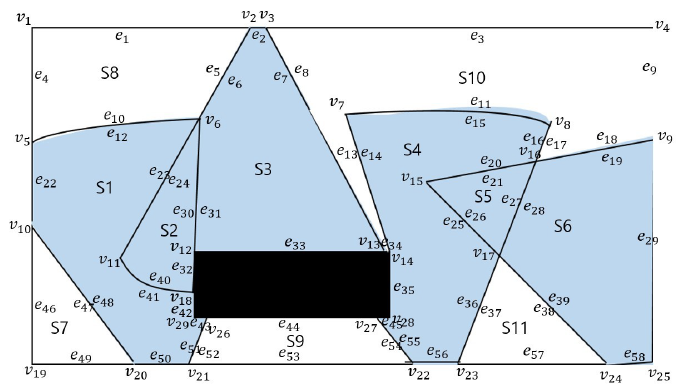
Figure 8. An example of constructing sensing area data structure.